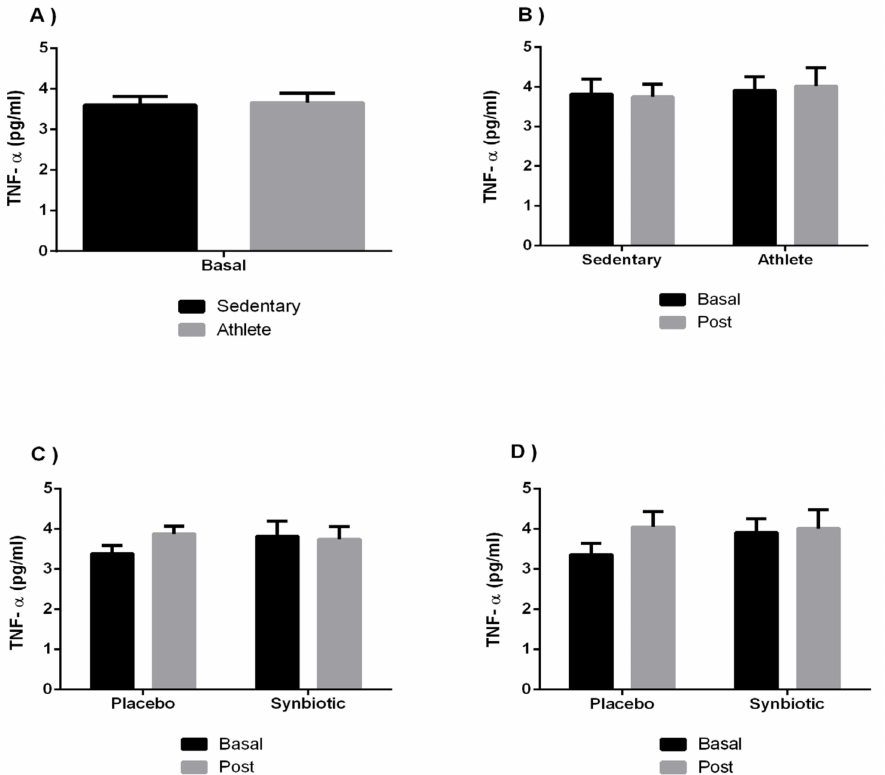
Figure 3. The effect of training and a synbiotic on the TNF- α cytokine. ( A ) Baseline serum TNF- α concentrations in sedentary men (n = 14) and athletes (n = 13). ( B ) Training effects on synbiotic effects on serum TNF- α concentration (n = 7 and n = 6 in sedentary and athlete groups, respectively). ( C ) Effect of synbiotic consumption on TNF- α in sedentary individuals with placebo (n = 7) or synbiotic (n = 7). ( D ) Effect of synbiotic consumption on TNF- α in athlete individuals with placebo (n = 6). The determinations are expressed by the mean ± SD of each of the samples. No significant differences were seen between groups ( p >